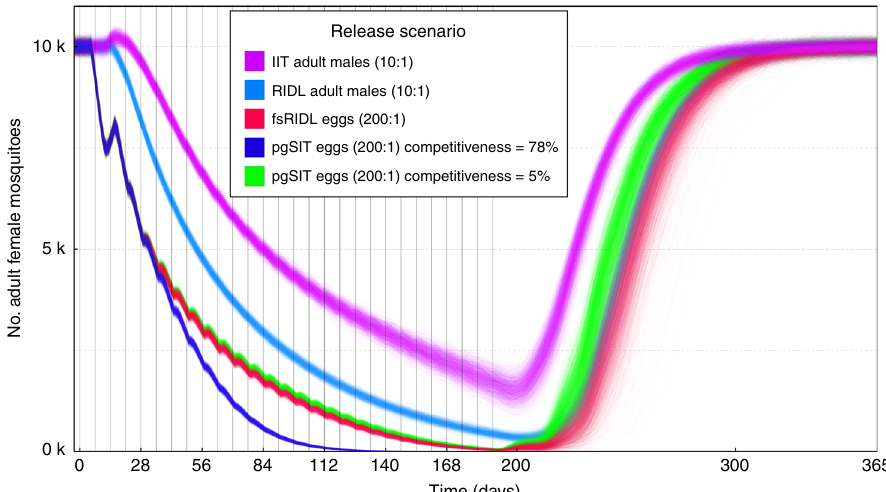
Fig. 1 Model-predicted impact of releases of pgSIT eggs on Aedes aegypti mosquito population density with comparison to releases of Wolbachia -based incompatible insect technique (IIT), release of insects carrying a dominant lethal gene (RIDL), and female-speci fi c RIDL (fsRIDL). Releases are carried out weekly over a 6-month period with release ratios (relative to wild adults) shown in the key. Model predictions were computed using 2000 realizations of the stochastic implementation of the MGDrivE simulation framework 5 for a randomly mixing Ae . aegypti population of 10,000 adult females and model parameters described in Supplemental Table 10 of Kandul et al. 1 Previous results suggested that pgSIT releases outcompete those of other suppression technologies when pgSIT mating competitiveness is estimated from lab experiments for Drosophila melanogaster (purple). However, pgSIT and fsRIDL perform similarly well when mating competitiveness is estimated from fi eld releases of RIDL strains of Aedes aegypti (green and red,